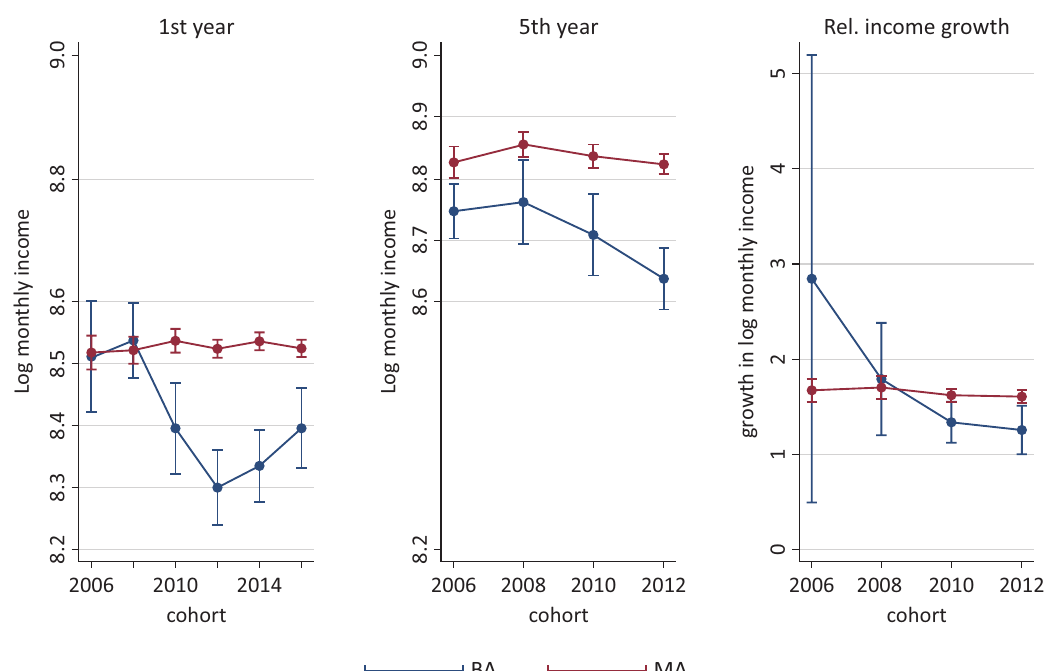
Figure 1. Linear predictions of interactions of university degree and cohort on gross monthly income (log) for men in the first and fifth year after graduation and their relative income growth. Data: SGS, own calculations. Note: See Table A5 in Appendix for further details.